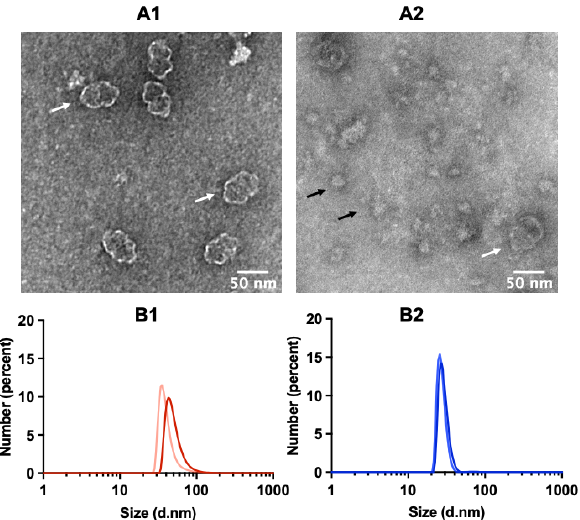
Figure 3. TEM images of vault nanoparticles stained by uranyl acetate, as detected in the void volume fraction ( A1 ) and in the following one ( A2 ). The fractions were analyzed after centrifuging at 20,000 × g and discarding the pellet. Vault particles are indicated by white arrows; contaminating matter, quite likely ribosomal components, are indicated by black arrows. DLS of the void volume fraction and the following one are shown in ( B1 ) and ( B2 ), respectively. Results are presented as number-weighted particle size distributions. ( B1 ): size 51.3 ± 15.6 (mean ± std. dev.); polydispersity index (PDI): 0.203. ( B2 ): size 28.9 ± 4.0; PDI 0.263. Result quality: good. In each panel, two